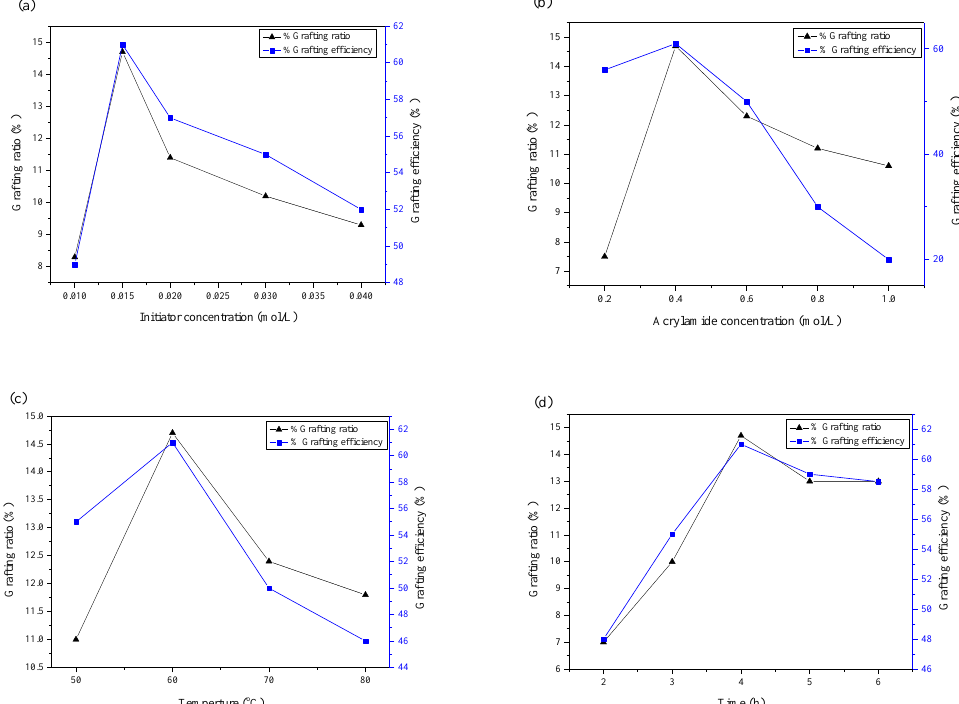
Figure 1. The influences of the synthesis conditions on the grafting ratio and the grafting efficiency of xylan-g-PAM. ( a ) The influence of initiator; ( b ) The influence of acrylamide; ( c ) The influence of temperature; and ( d ) The influence of temperature.